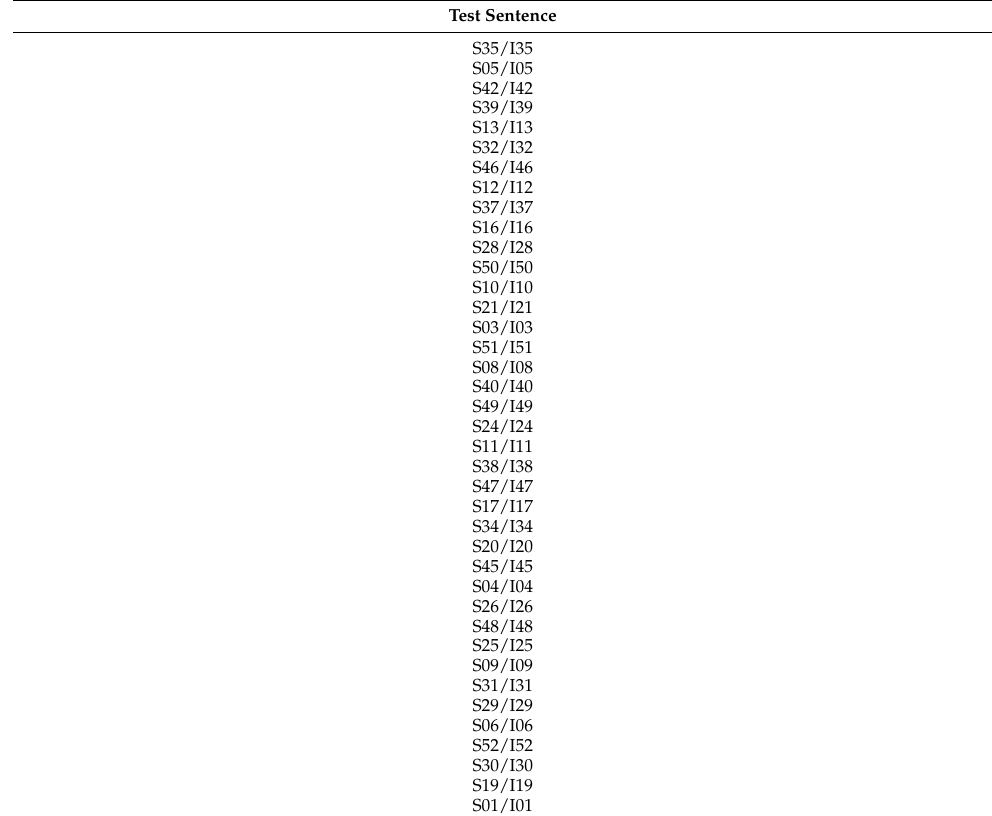
Table A5. Order of